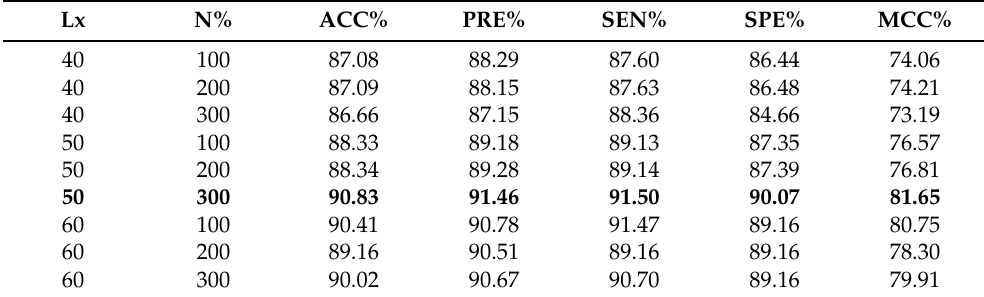
Table 2. Performance of ACP-ADA with parameters ‘Lx’ and ‘N’ on the ACP240 dataset along with performance metrics (the best metrics are shown in